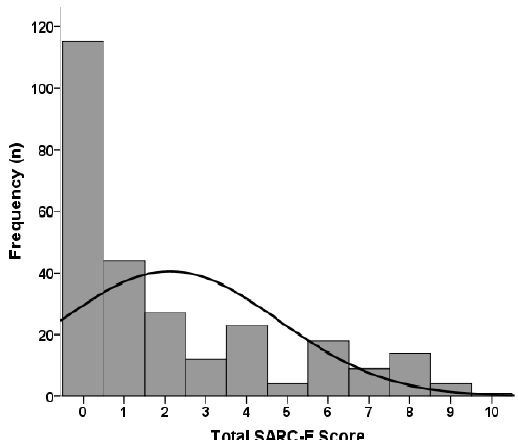
Figure 1. SARC-F distribution among 271 hemodialysis patients.